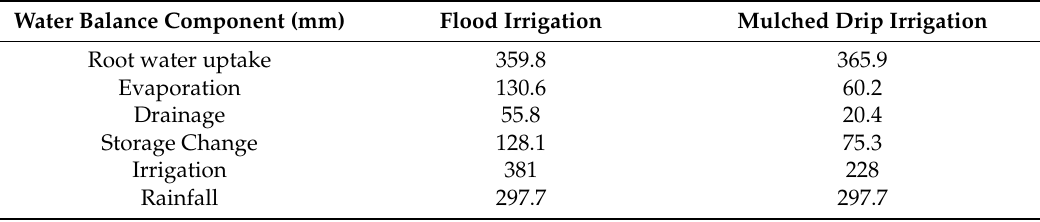
Table 5. Simulated water balance under flood irrigation and mulched drip irrigation.